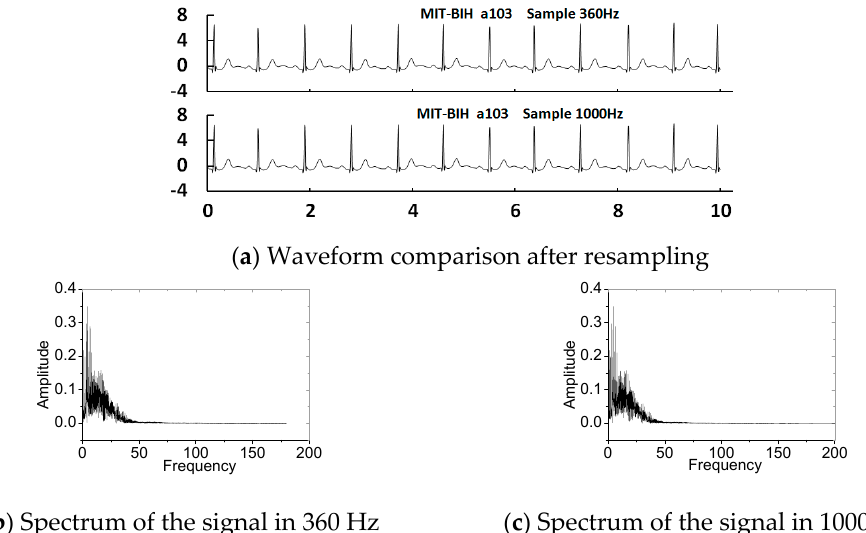
Figure 5. Waveform and spectrum before and after resampling of Ch8 in the DaISy database.